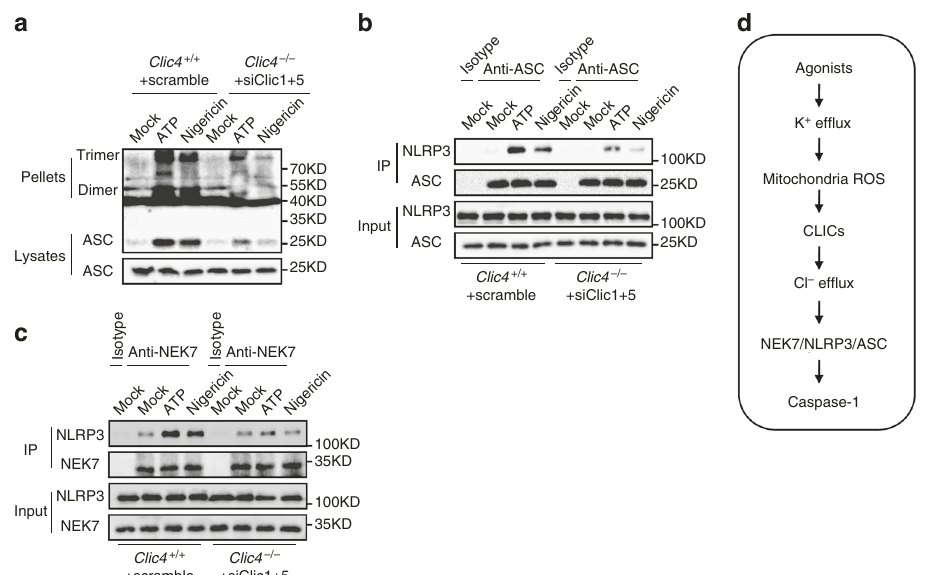
Fig. 8 Clics are important for NLRP3 in fl ammasome assembly. a Immunoblot analysis of ASC oligomerization in lysates of LPS-primed Clic4 – / – BMDMs transfected with siRNA against Clic1 and Clic5 and left stimulated with ATP or nigericin. b Immunoprecipitation (IP) and immunoblot analysis of the interaction of endogenous NLRP3 and ASC in LPS-primed Clic4 – / – BMDMs transfected with siRNA against Clic1 and Clic5 , and left stimulated with ATP or nigericin. c IP and immunoblot analysis of the interaction of endogenous NLRP3 and NEK7 in LPS-primed Clic4 – / – BMDMs transfected with siRNA against Clic1 and Clic5 , and left stimulated with ATP or nigericin. d Model for the function and mechanism of Clics and chloride ef fl ux in NLRP3 in fl ammasome activation. Data are representative of three independent experiments a –